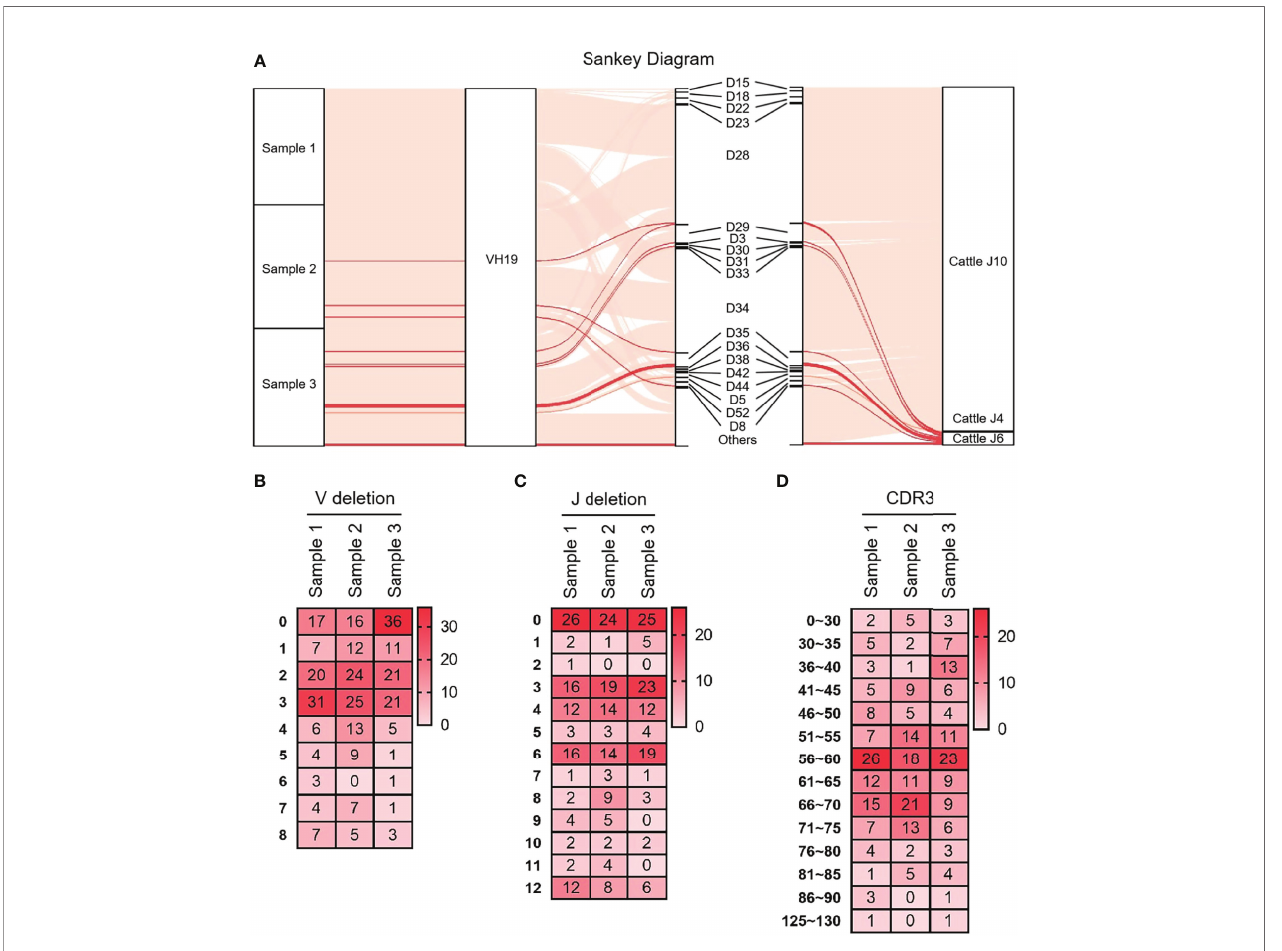
FIGURE 3 | The diversity of VDJ recombination and CDR3 length in yak IgH. (A) The sankey diagram of VDJ recombination in yak IgH; (B) the random deletion nucleotides of VH gene in yak IgH; (C) the random deletion nucleotides of JH gene in yak IgH; (D) the nucleotides of CDR3 in yak